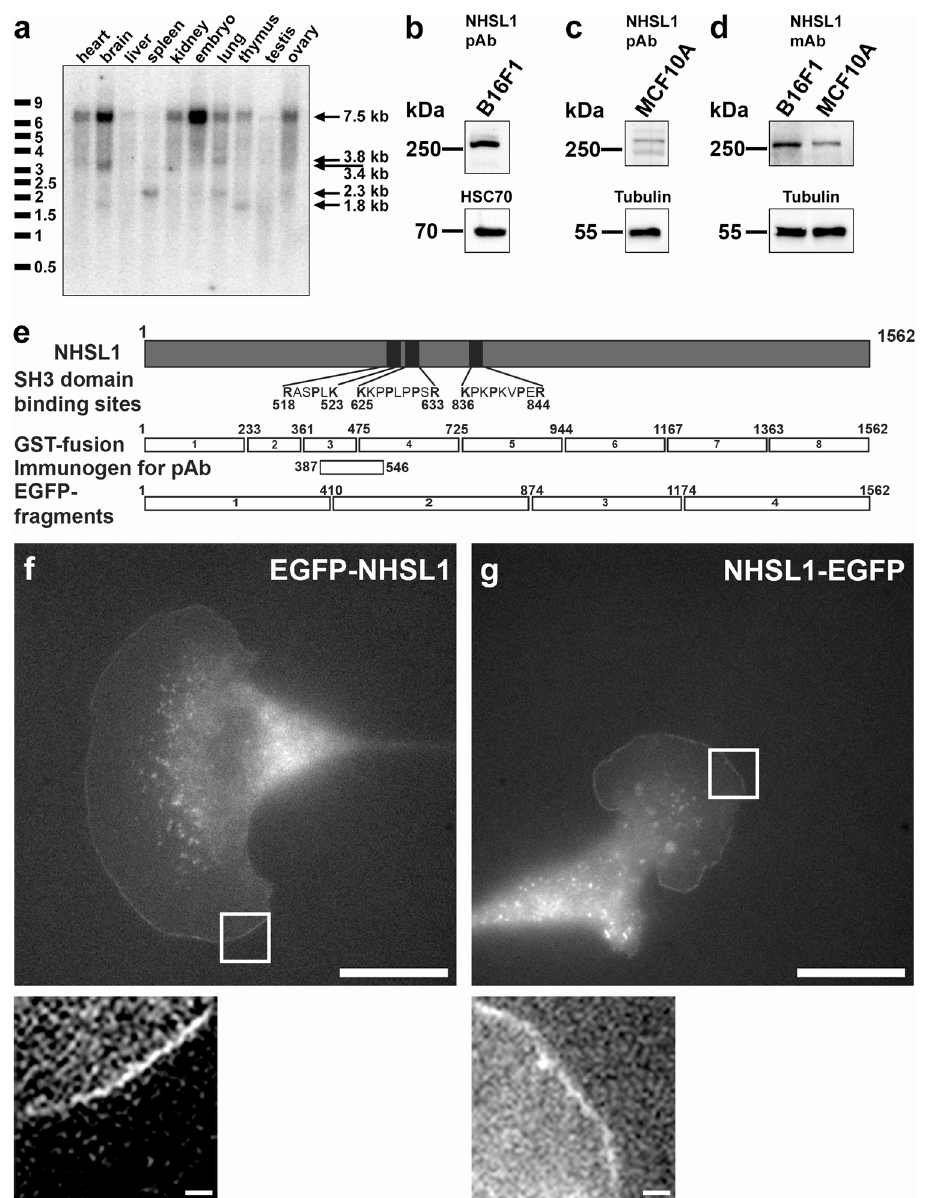
Fig. 1 NHSL1 localises to the very edge of lamellipodia. a Northern blot analysis of NHSL1 expression in different murine tissues. Arrows show a large 7.5 kb isoform that is ubiquitously expressed and various shorter isoforms with varying tissue speci fi c distribution. b – d Western blots detecting NHSL1 protein in the indicated cell lines using the b , c polyclonal (4457) or d monoclonal antibody (C286F5E1). For full blots see Supplementary Fig. 1a – c. e Scheme of NHSL1 protein (grey rectangle) containing three putative SH3 binding sites (indicated black boxes). GST-fusion proteins 1 – 8 and EGFP-fusion proteins 1 – 4 of NHSL1 are indicated (white rectangles). Immunogen for the NHSL1 polyclonal antibody is indicated. f , g N-terminal EGFP-tagged NHSL1 ( f ) and C-terminal EGFP-tagged NHSL1 ( g ) were expressed in B16-F1 cells and, after plating on laminin, localisation of both EGFP-tagged NHSL1 constructs were imaged live. Scale bar: 20 μ m. Inset represents a magni fi ed view of the white box. Scale bar in the inset: 1.25 μ m. Representative blots or images shown from a one and b – d , f , g three independent biological experiments. See also related Supplementary Movie